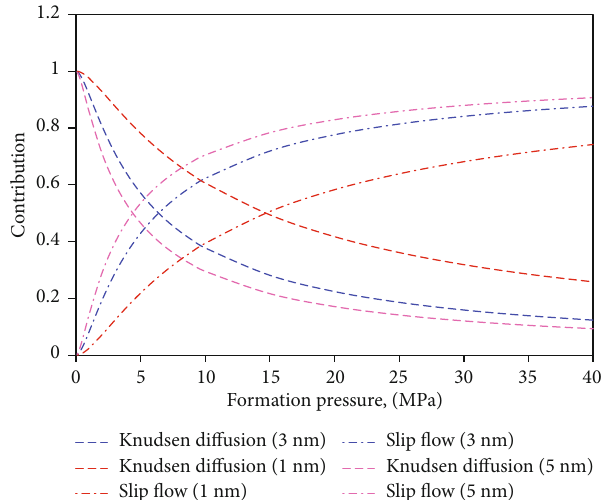
Figure 7: Contribution of di ff erent transport mechanisms during the production process.